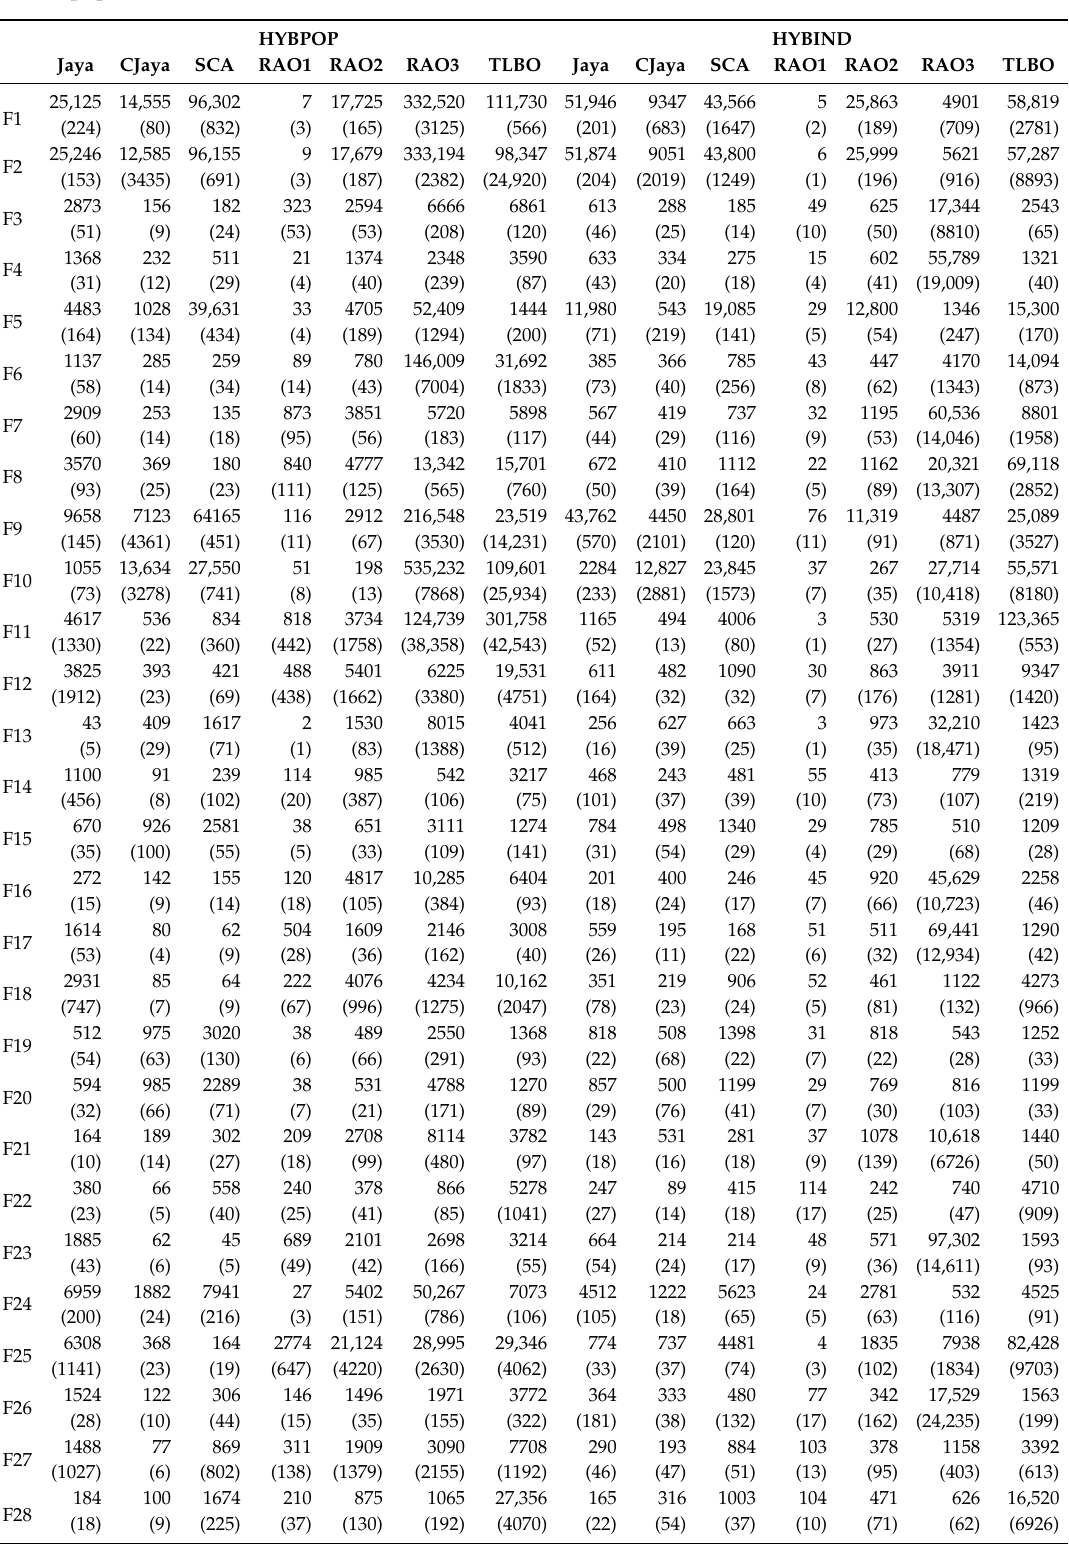
Contribution of each algorithm to the replacements of the individuals (NoR-AI). The population size is set as